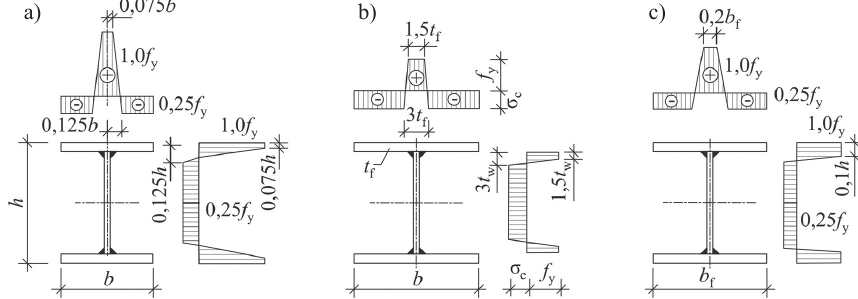
Fig. 6. Welding stress distribution according to: a) eccs (1983); b) Johansson et al. (2007); c)